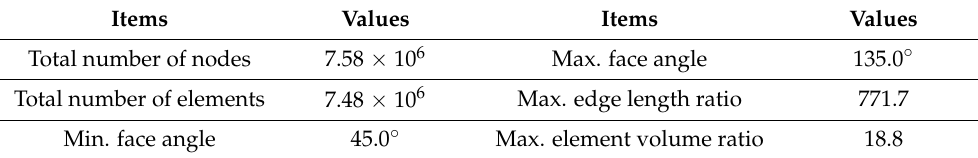
Figure 4. Grid system for six-stage orifice. Table 2. Grid information for six-stage